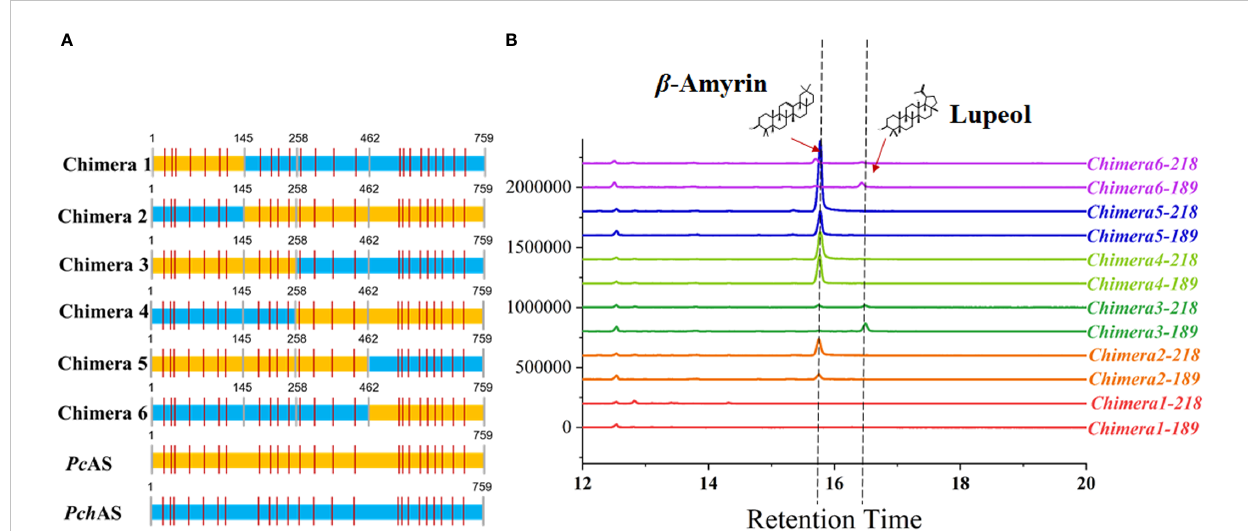
FIGURE 3 Functional characterization of chimera protein. (A) Diagram of the chimera protein. The colors indicate that fragment source: P. chinensis (blue) and P. cernua (yellow). (B) GC – MS analysis of chimera protein expressed yeast extraction. ERG7-de fi cient yeast that transformed with pESC-His empty vector was used as control. The 218 and 189 ion counts of b -amyrin and lupeol are shown, respectively. PcAS represent AS gene cloned from P. cernua , PchAS represent AS gene cloned from P. chinensis